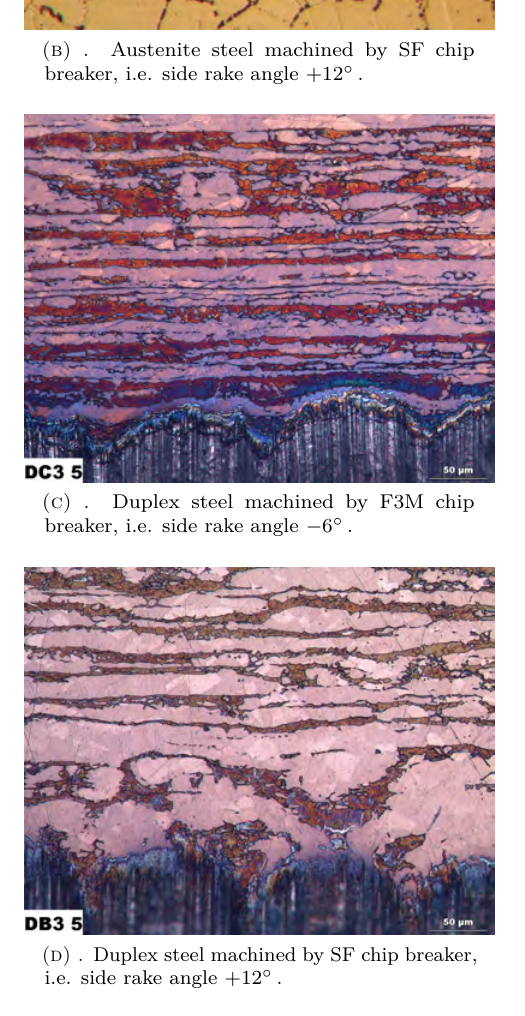
Figure 5. Optical microscopy images of the radial cut of four samples; magnification 250 × , electrolytic etching 10% oxalic acid.